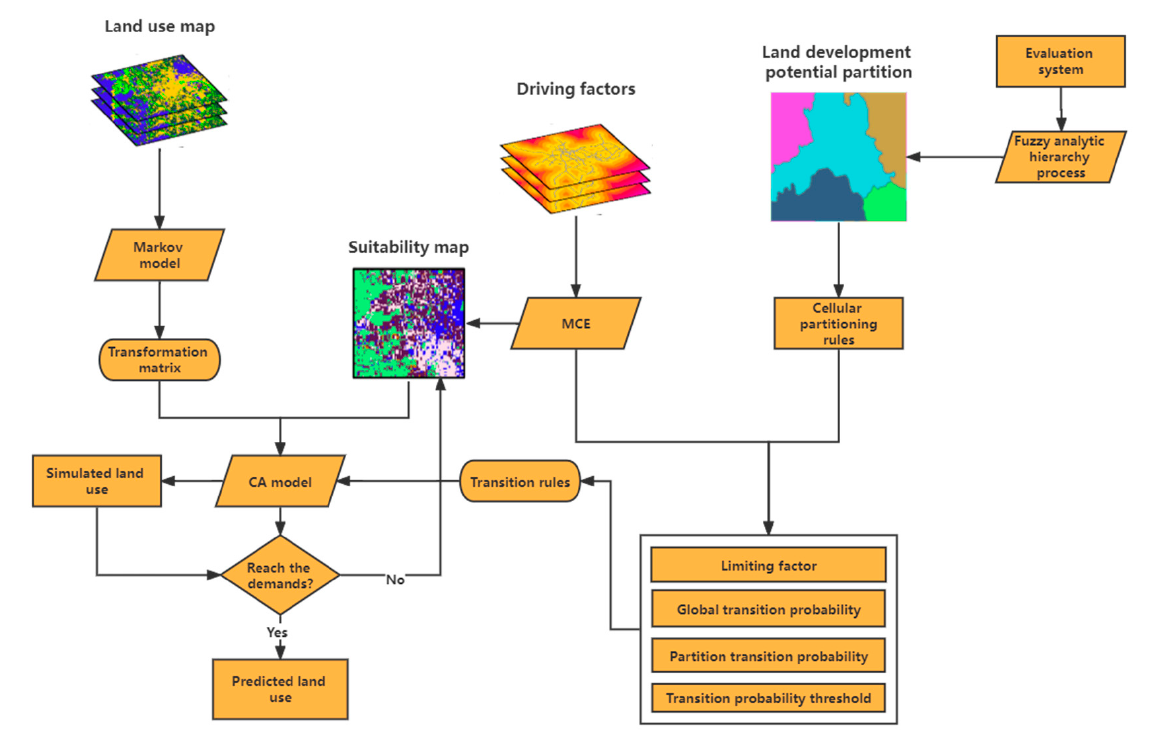
Figure 3. The framework for PHLUS.